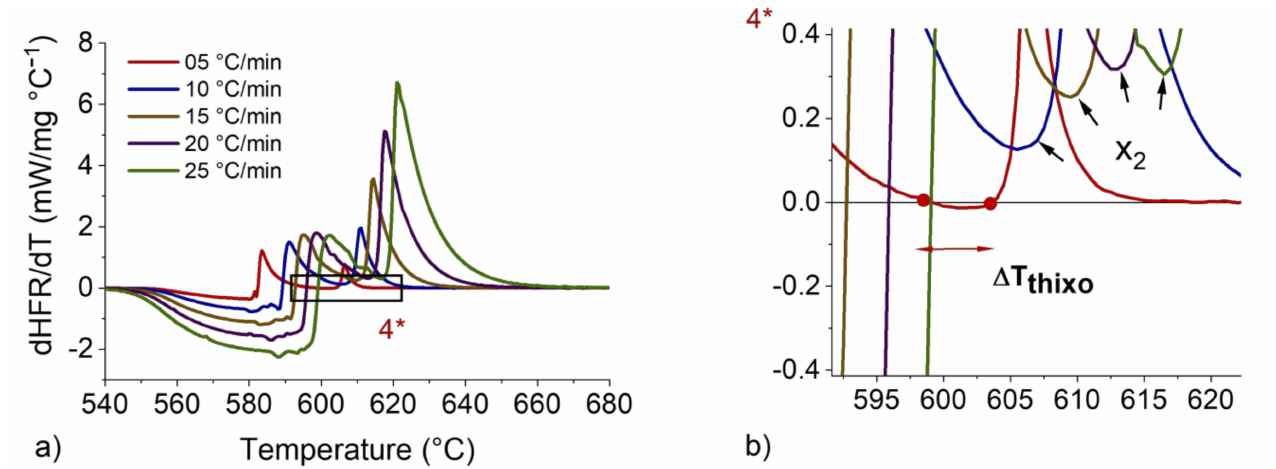
Figure 9. dHFR / dT vs. T curve for 7 wt.%Si with heating rates from 5 to 25 ◦ C/min and sample mass of 90 mg ( a ). Magnification at the ∆ T THIXO zone ( b